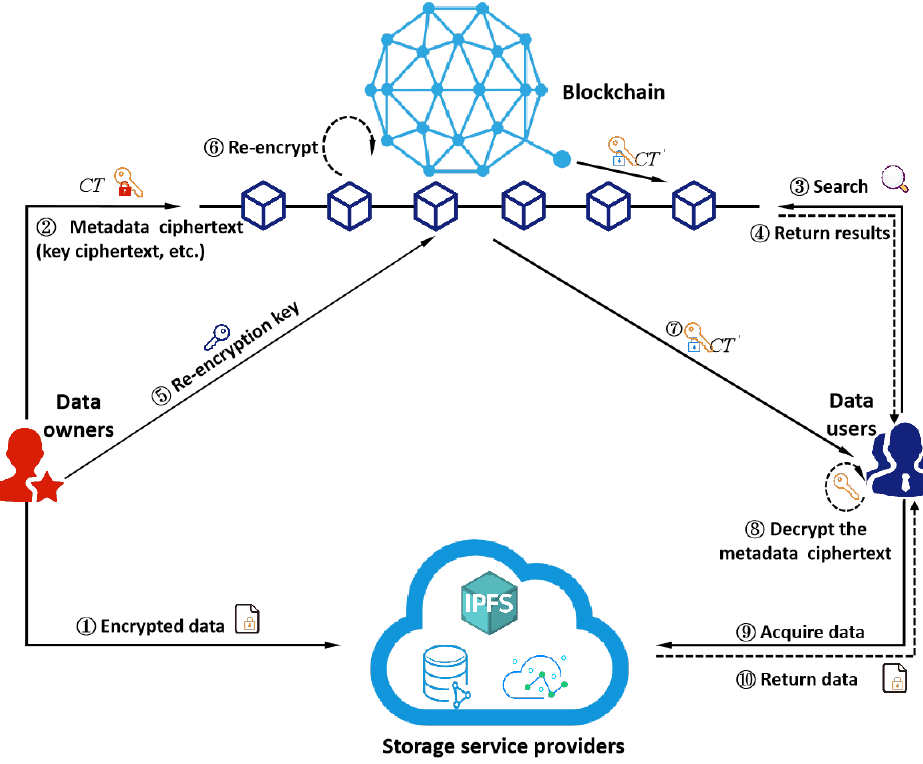
Figure 3. The overview of our data-sharing